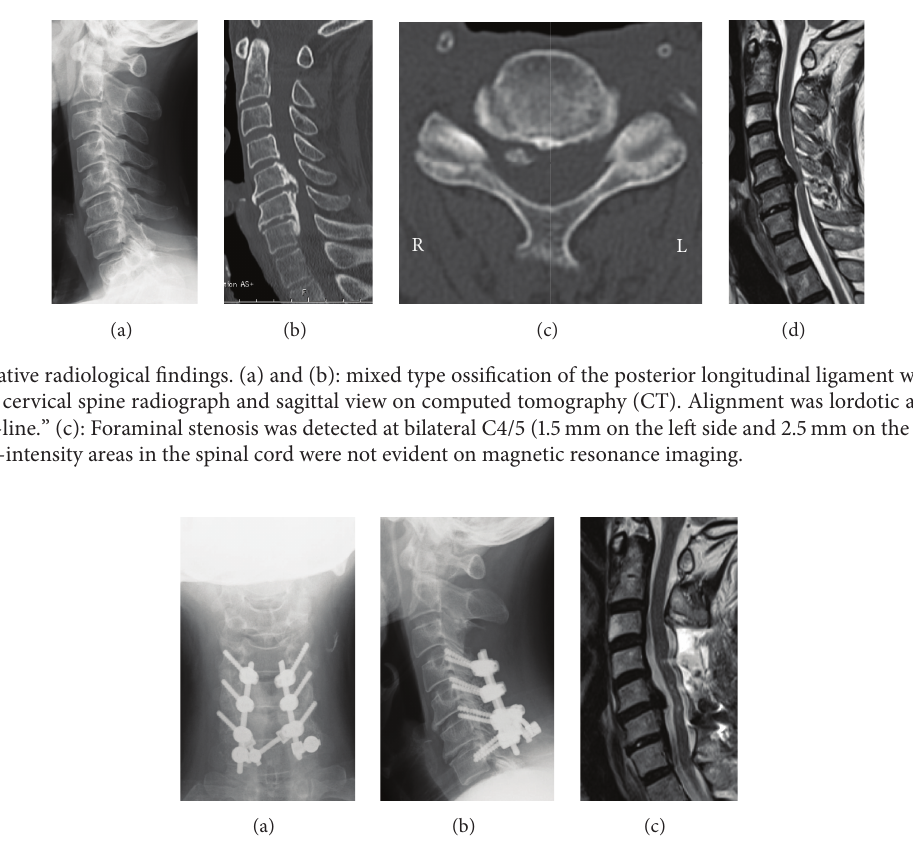
Figure 2: Postoperative X-ray and magnetic resonance imaging. (a) and (b): anteroposterior and lateral view X-ray of the cervical spine. (c): magnetic resonance imaging showed sufficient decompression of the spinal cord and posterior shifting, without high-intensity areas at